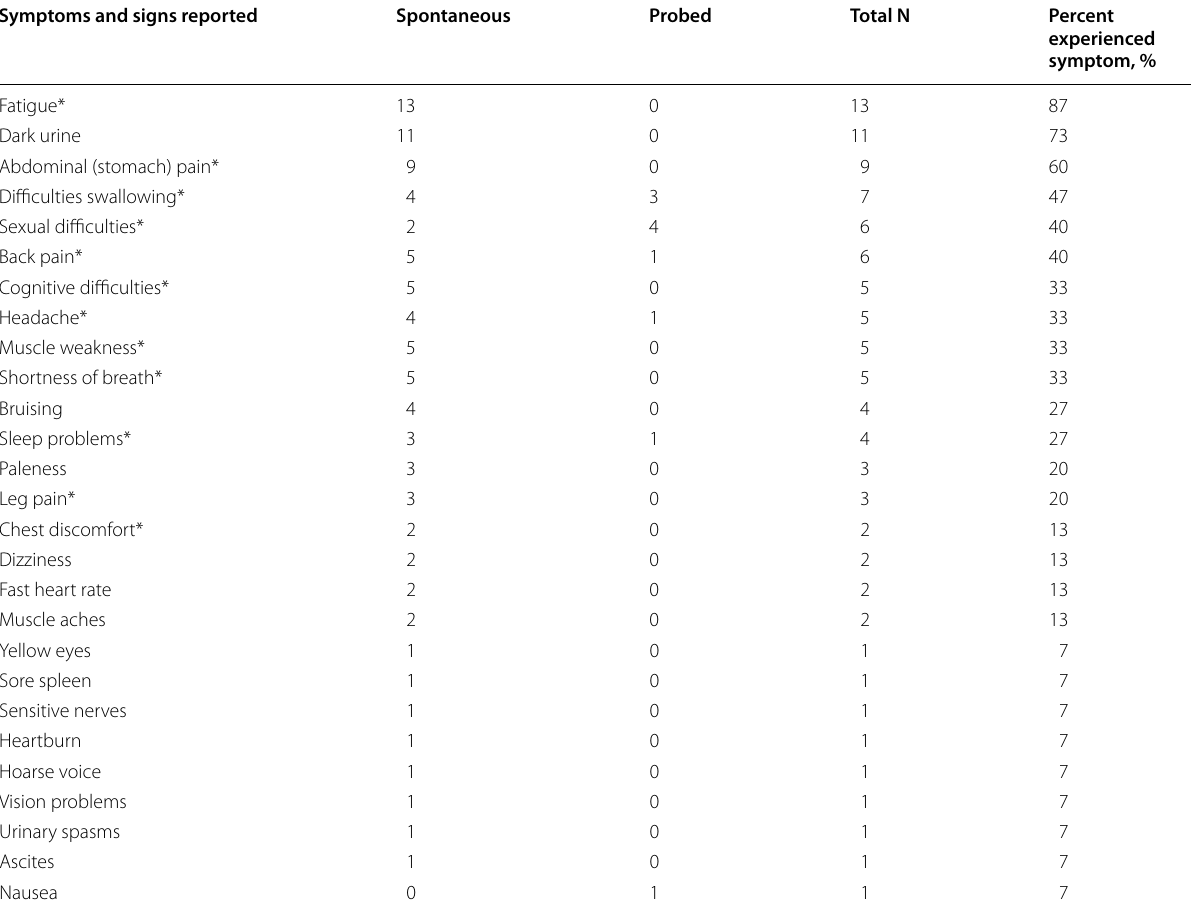
Table 2 Signs and symptoms reported during concept elicitation (N